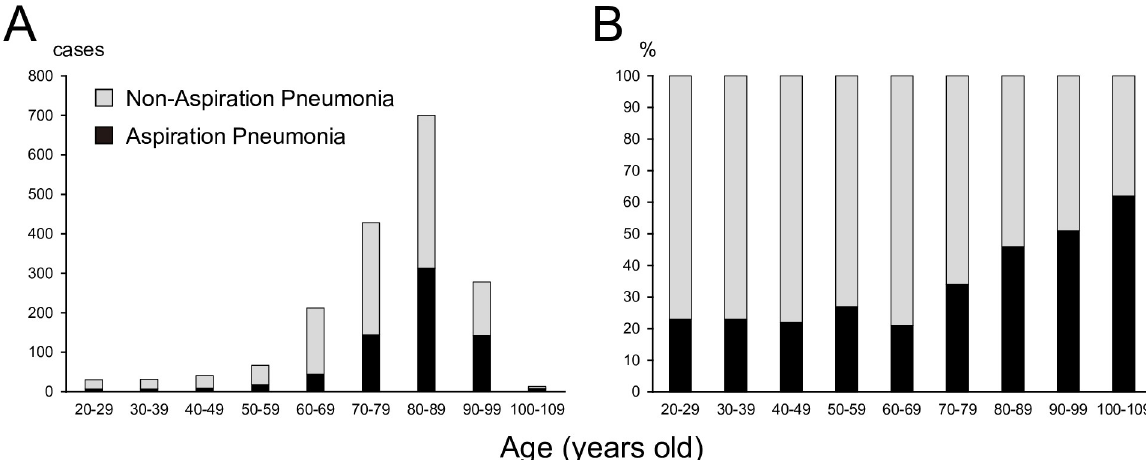
Fig 3. The ratio of aspiration pneumonia to total pneumonia cases. A: The number of hospitalized aspiration and non-aspiration pneumonia patients according to age. B: The percentages of aspiration and non-aspiration pneumonia patients in total hospitalized pneumonia patients according to